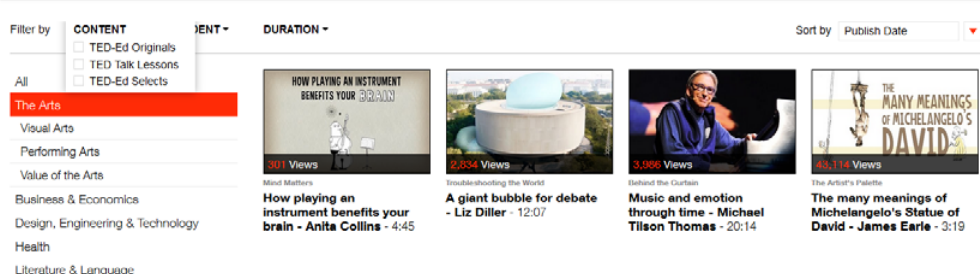
Figure 2 . Example of website video lesson display by